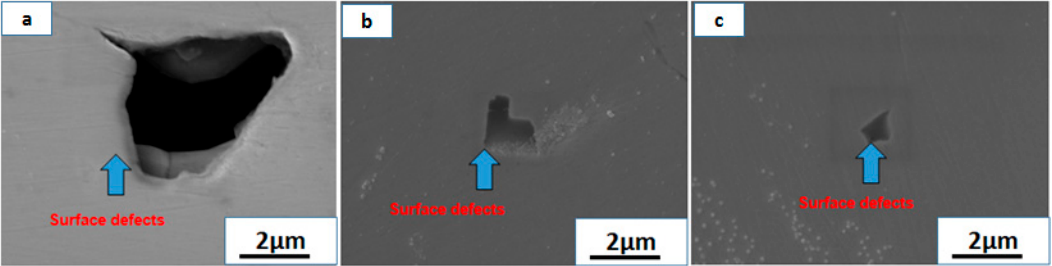
Figure 10. SEM images of the surface defects of the rhenium ingots (( a ) prepared by 52.15 µm D 50 Re powders, ( b ) prepared by 34.04 µm D 50 Re powders, ( c ) prepared by 19.74 µm D 50 Re powders).